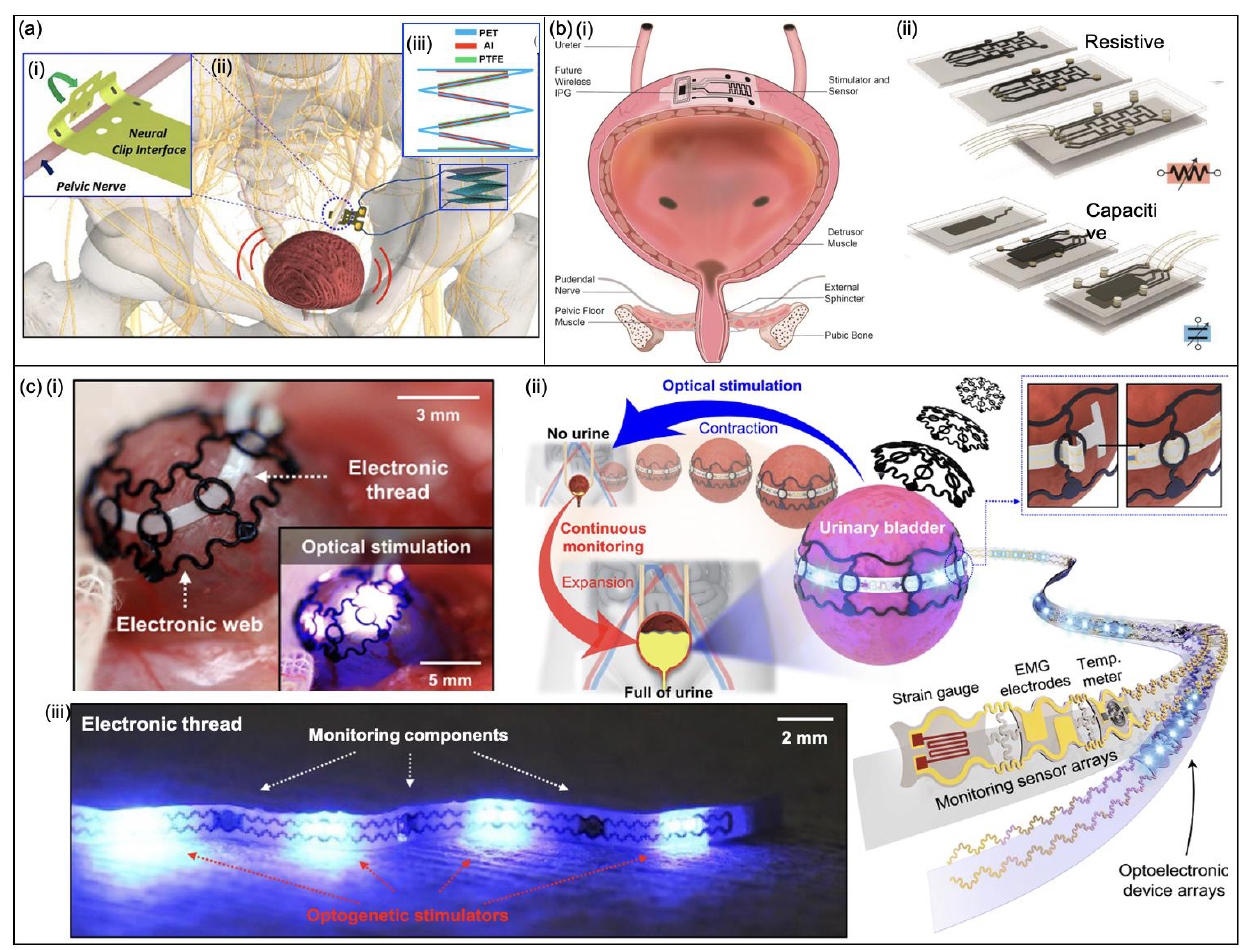
Figure 11. Stimulation devices for UAB. ( a , i ) The FNC neural chip implanted on the peripheral nerve, ( ii ) the mechano-neuromodulation pelvic nerve stimulation system using a triboelectric neurostimulator, and ( iii ) the four-layer stack triboelectric nanogenerator (TENG) [65].